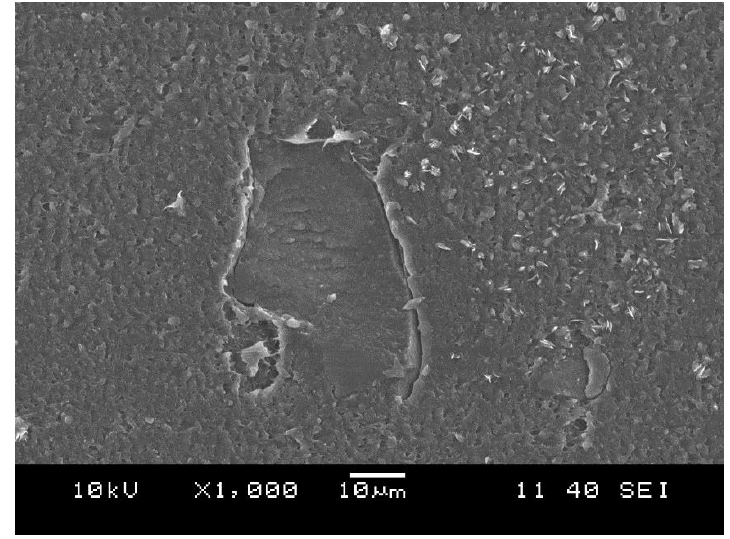
Figure 11. Cryomicrotomed surfaces of the TDV with 10 wt % dCR in the rubber phase.